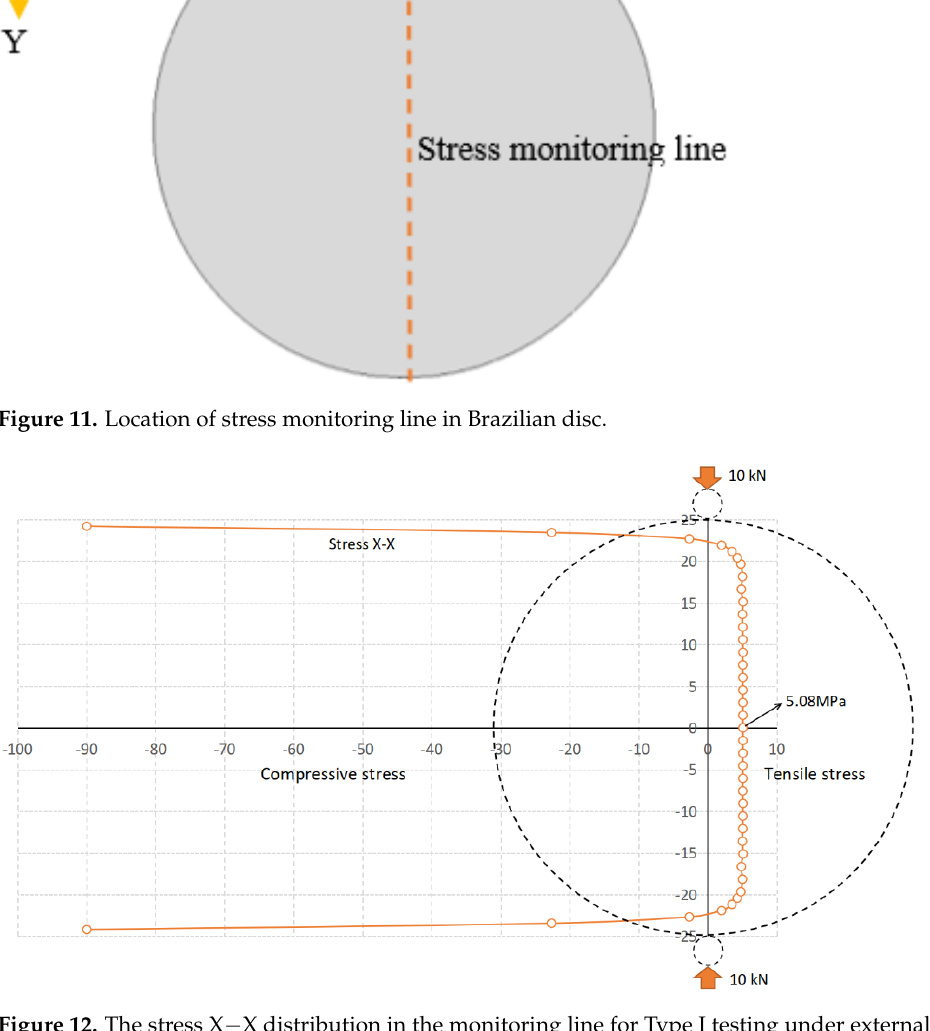
Figure 12. The stress X − X distribution in the monitoring line for Type I testing under external load of 10 kN.